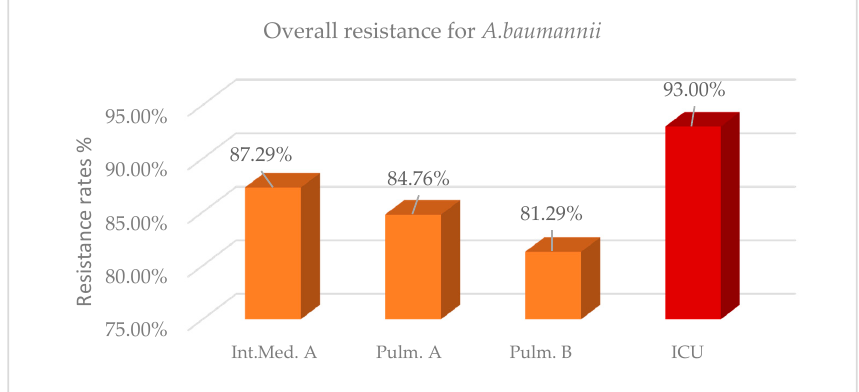
Figure 2. Resistance rates for Acinetobacter baumannii per ward during the 2-year period (2017–2018).